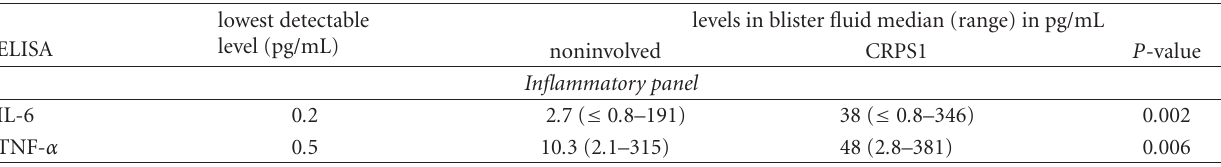
Table 2: Cytokine levels in blister fluids from 22 patients with complex regional pain syndrome measured by ELISA. Blister fluids were diluted 4-fold in matrix bu ff er. Lowest detectable level: lowest detectable standard which significantly di ff ers from zero standard (experi- mentally